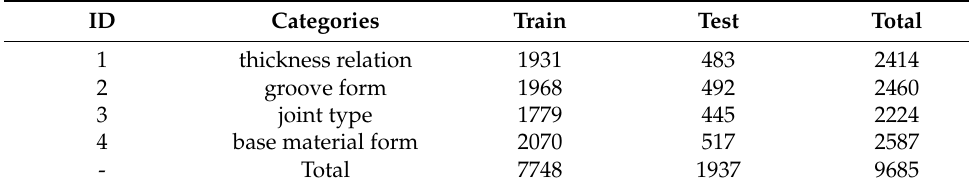
Table 3. Data allocation information.